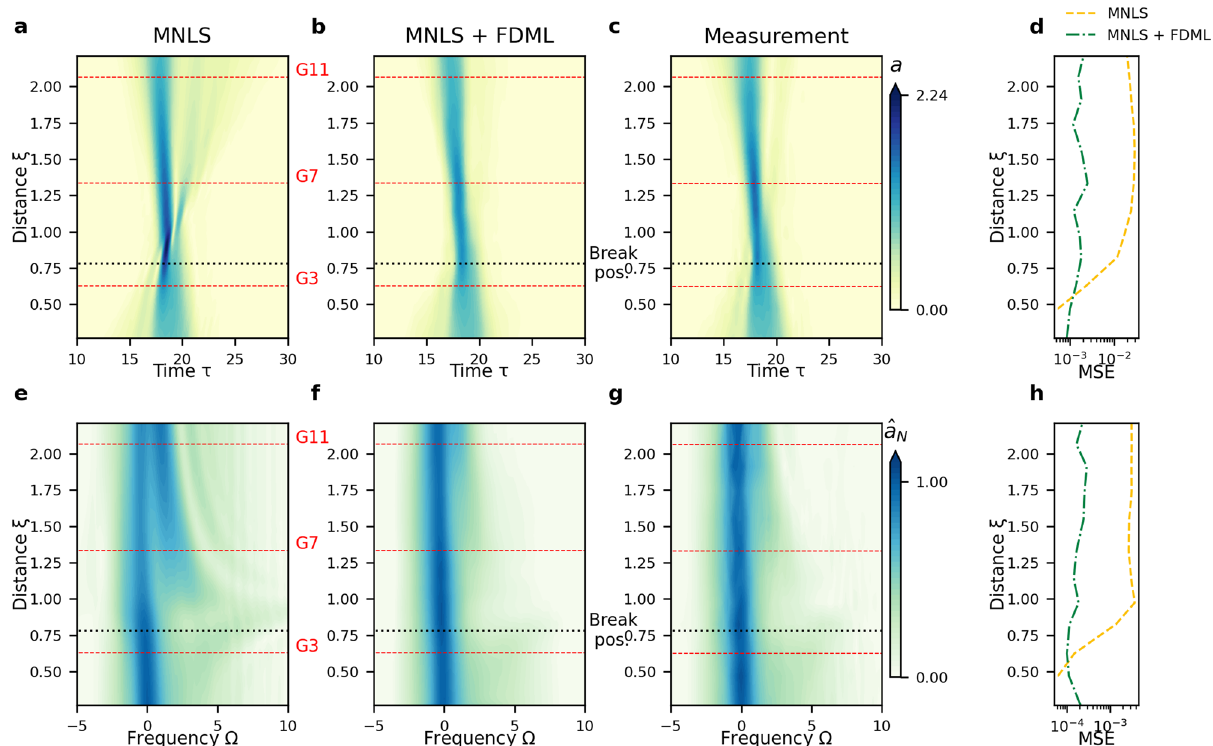
Fig. 2 Example result (not used for training) for the evolution of focused irregular waves (Wave Category II) showing wave breaking at ξ = 0.78, as indicated by the black dotted line. a – d Time domain. Color bar indicates surface elevation envelope a . a MNLS simulations. b MNLS + FDML simulations. c Measurements. d Mean squared error (MSE) at each wave gauge between measured envelope and MNLS and MNLS + FDML. e – h Frequency domain, similar panel con fi guration as in the time domain, with the color bar indicating the magnitude of the spectrum normalized by the maximum of the initial condition ( ^ a N ). The horizontal red dashed lines correspond to the gauge locations examined in Fig.